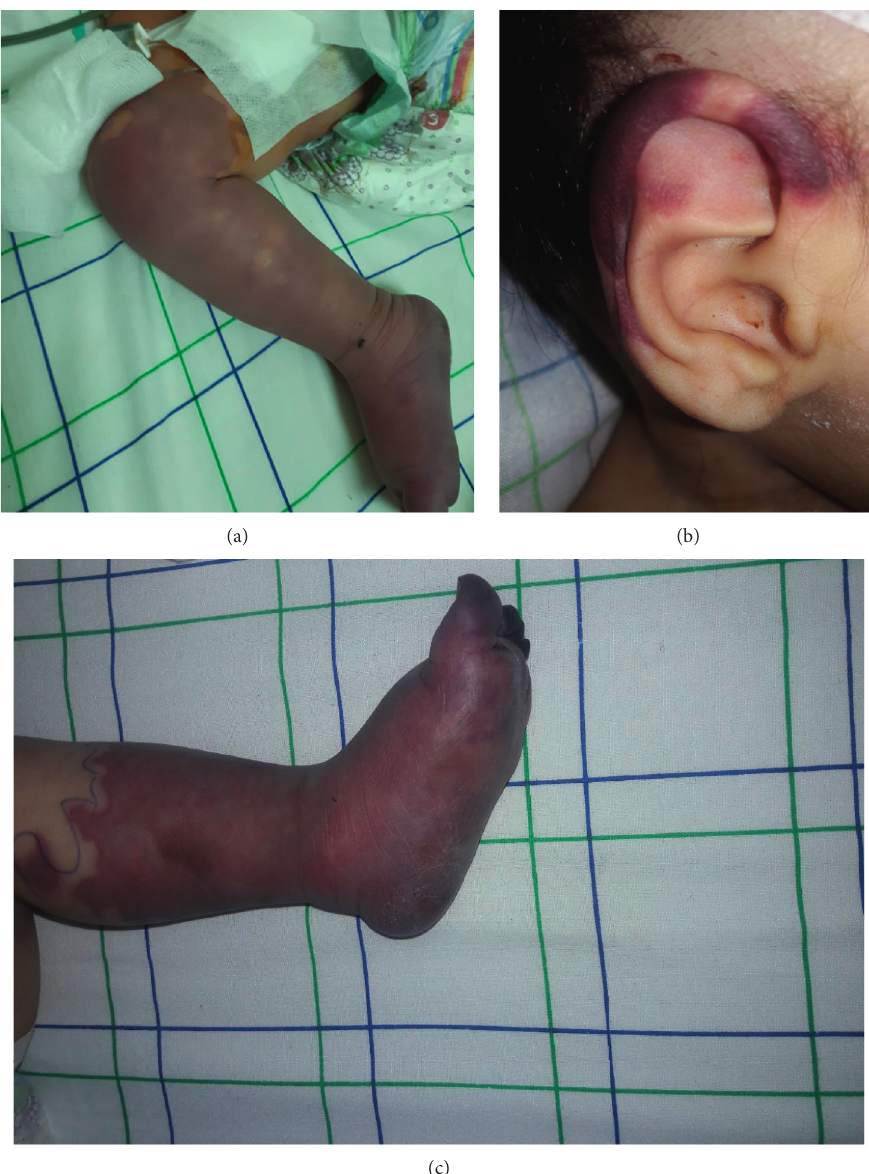
Figure 1: (a) An eleven-month-old boy with acral necrosis of the right foot. (b, c) A seven-month-old boy with distal necrosis of the foot and